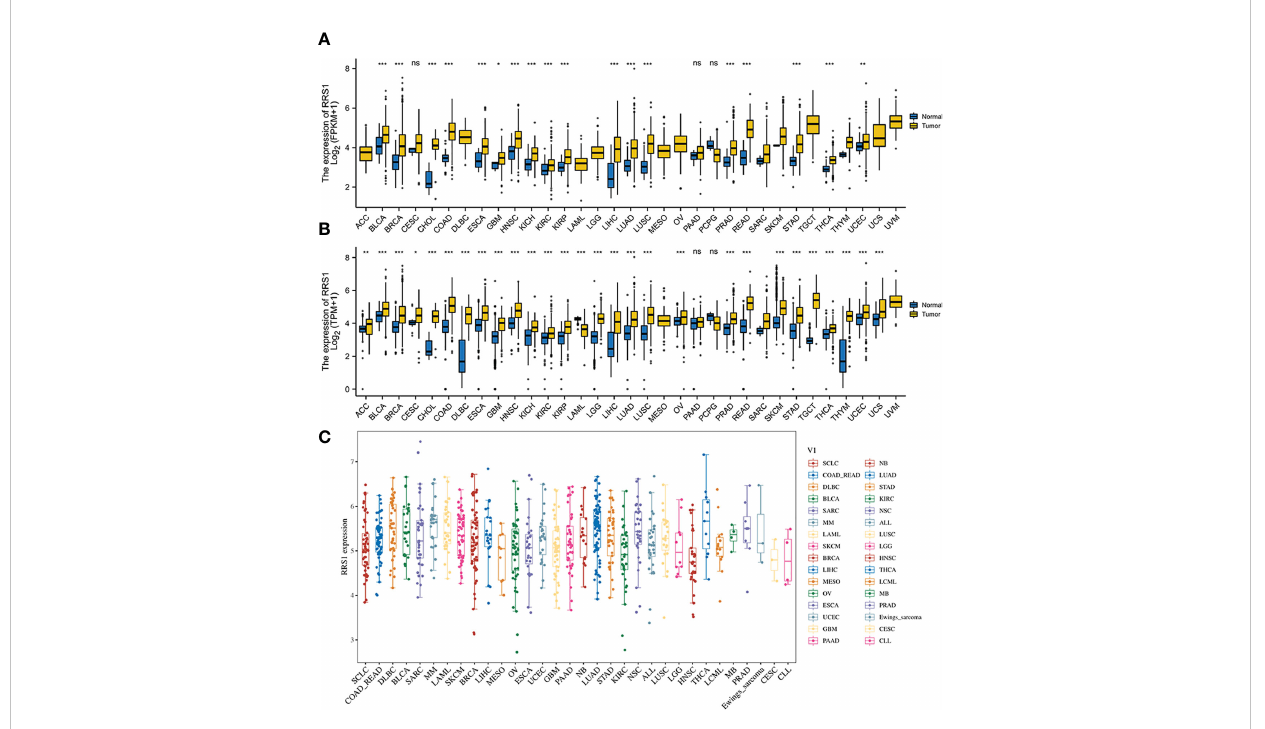
FIGURE 10 The expression of RRS1 in pan-cancer. (A) In the TCGA database, the expression of RRS1 in diverse cancers. (B) In the TCGA and GTEx databases, the expression of RRS1 in diverse cancers. (C) RRS1 expression in different cell lines. *p < 0.05, **p < 0.01, ***p <0.001. ns, no signi fi cance.